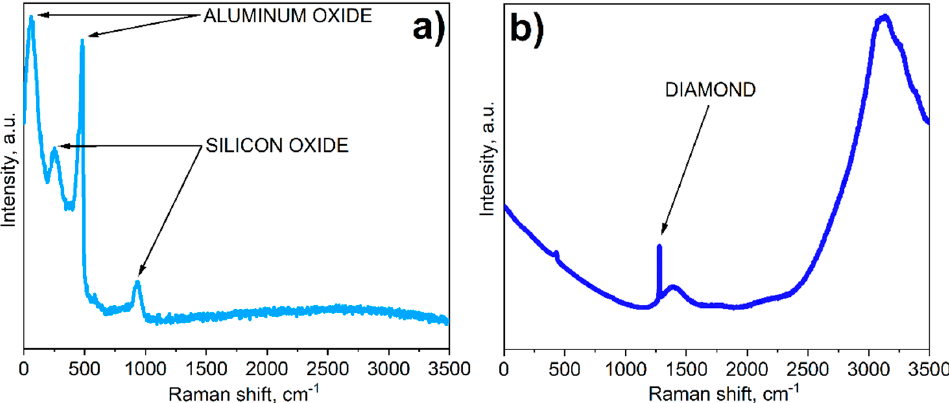
Figure 5. Raman spectra of AlSi10MgCu powder coated with diamond particles: ( a ) spectrum of the initial powder; ( b ) powder coated with diamond fraction 500 nm.